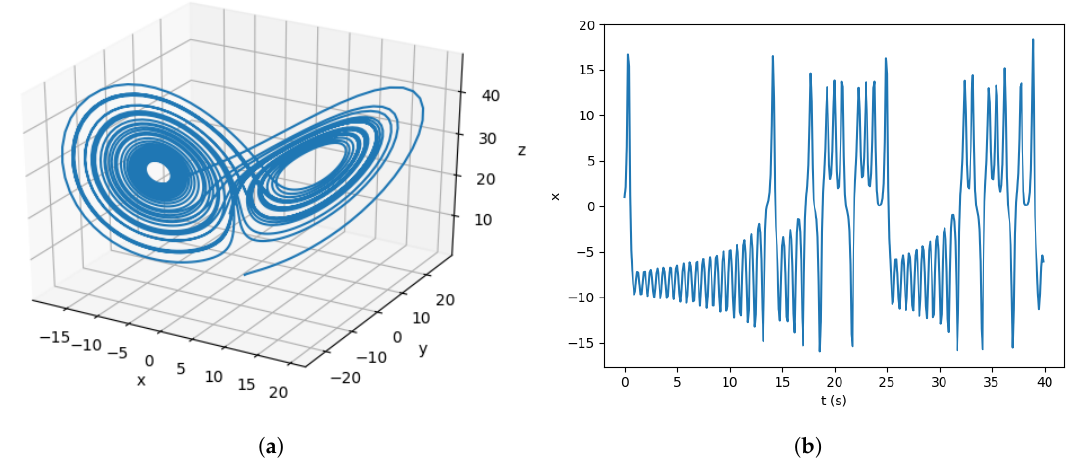
Figure 5. Lorenz system result data. ( a ) Three-dimensional data. ( b ) First dimension time series.